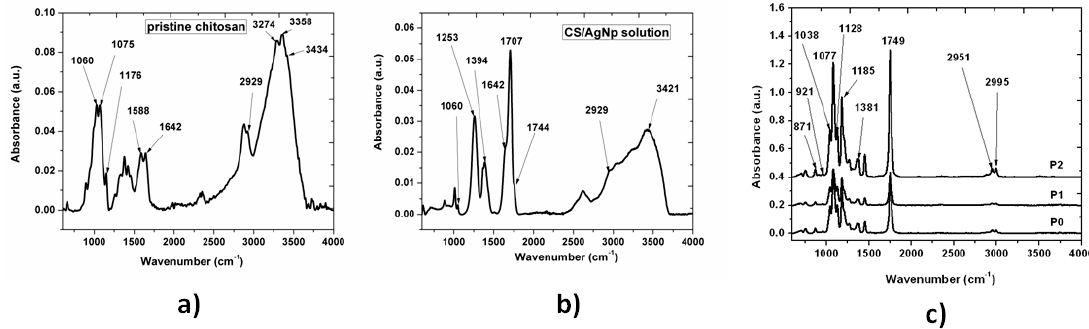
Figure 5. Fourier Transform Infrared (FTIR) results for ( a ) pristine chitosan; ( b ) CS/AgNp solution; ( c ) pristine and treated PLLA samples.